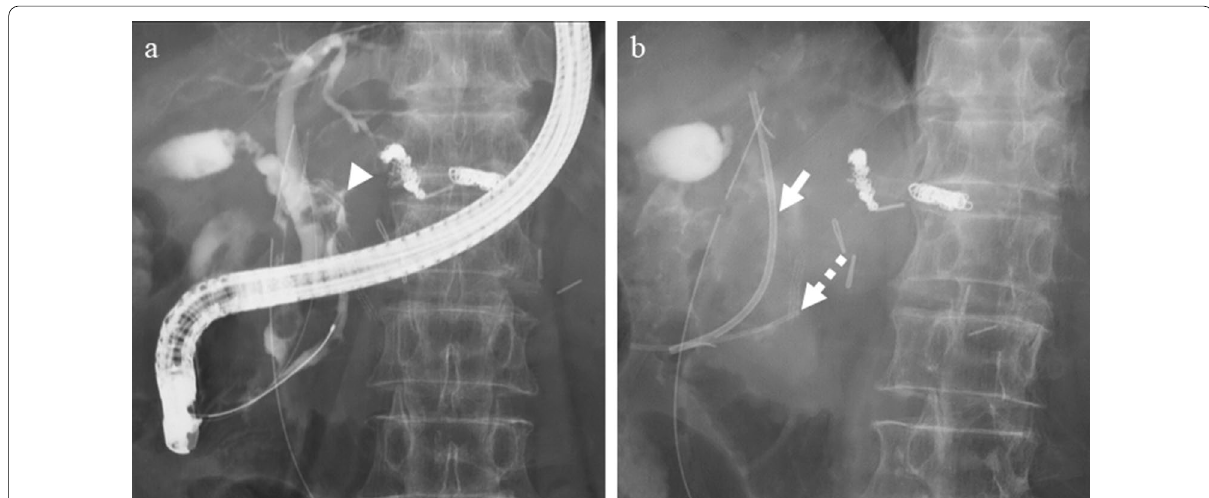
Fig. 4 Endoscopic retrograde pancreatography at postoperative day 9. a , b Leakage from the main pancreatic duct (arrowhead), ERBD (arrow), and ERPD (dotted arrow)